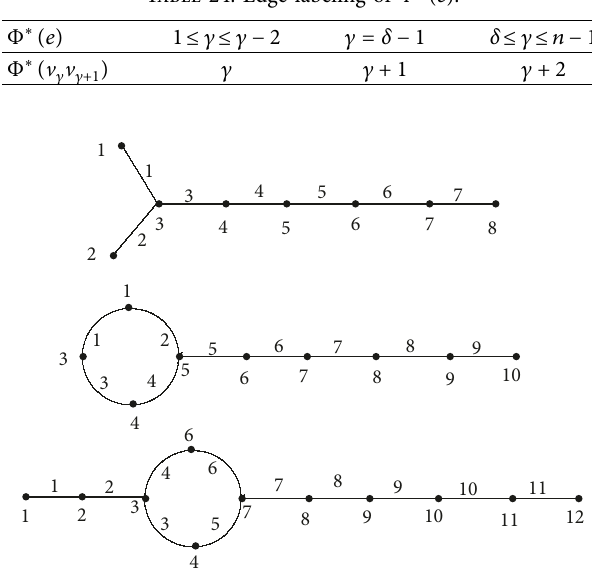
Table 24: Edge labeling of Φ ∗ ( e ) .